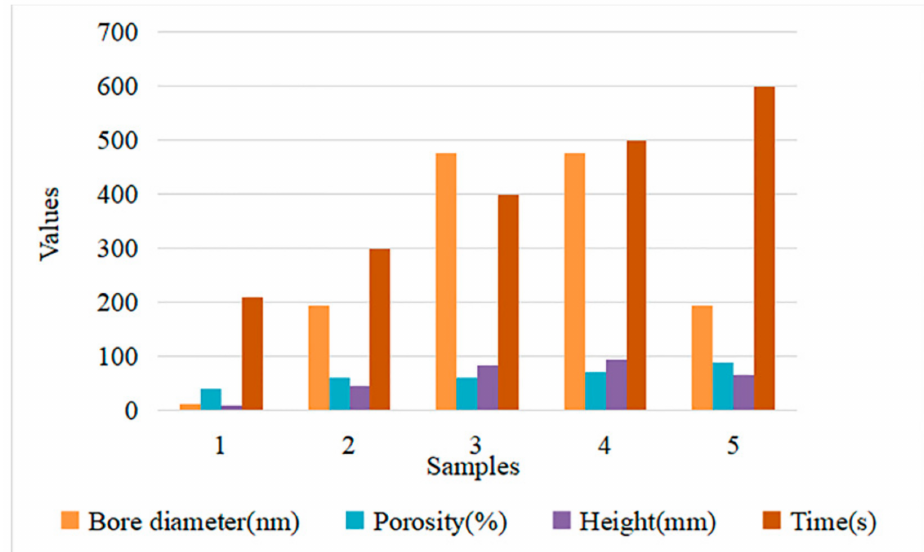
Figure 4. Sample values of real dyeing